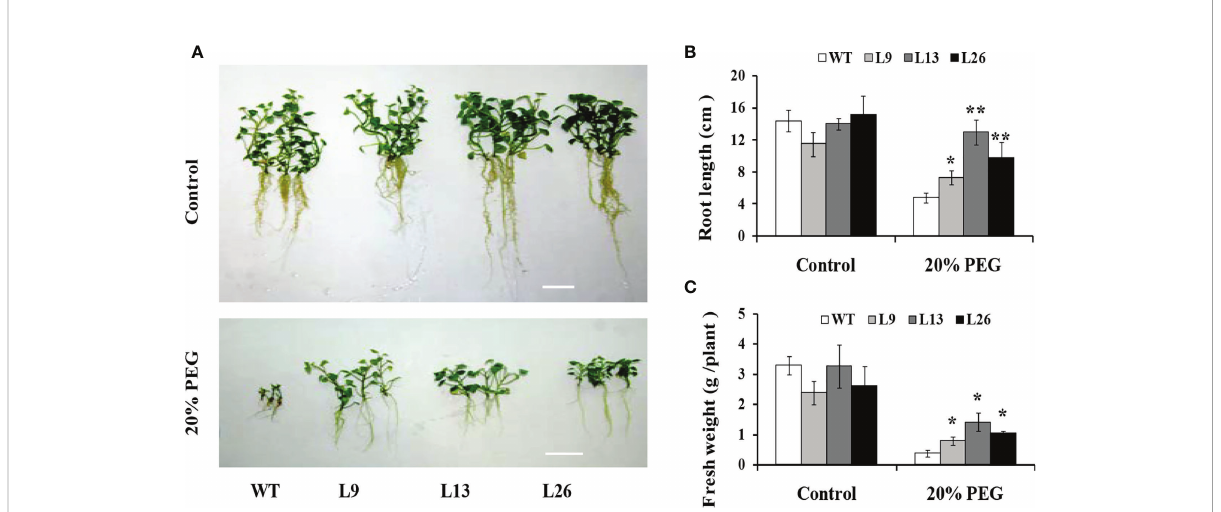
FIGURE 3 Responses of in vitro -grown transgenic sweet potato plants and WT cultured on MS medium without (control) or with 20% PEG6000 for 4 weeks. (A) Phenotypes. (B) Root length. (C) Fresh weight. The data are presented as the mean ± SEs (n = 3). * and ** indicate signi fi cant differences from that of WT at P <0.05 and P <0.01, respectively, according to Student ’ s t